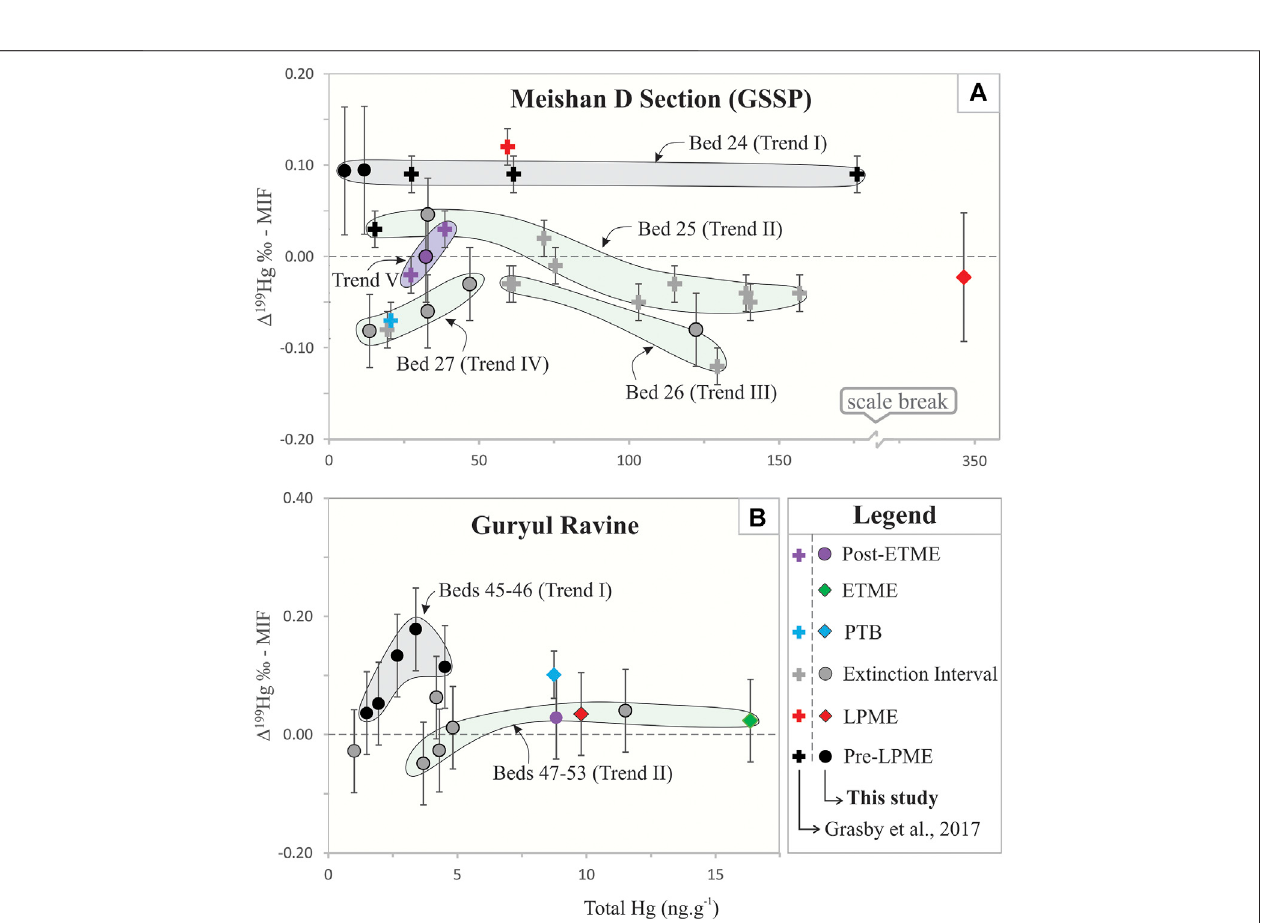
Frontiers in Earth Science |